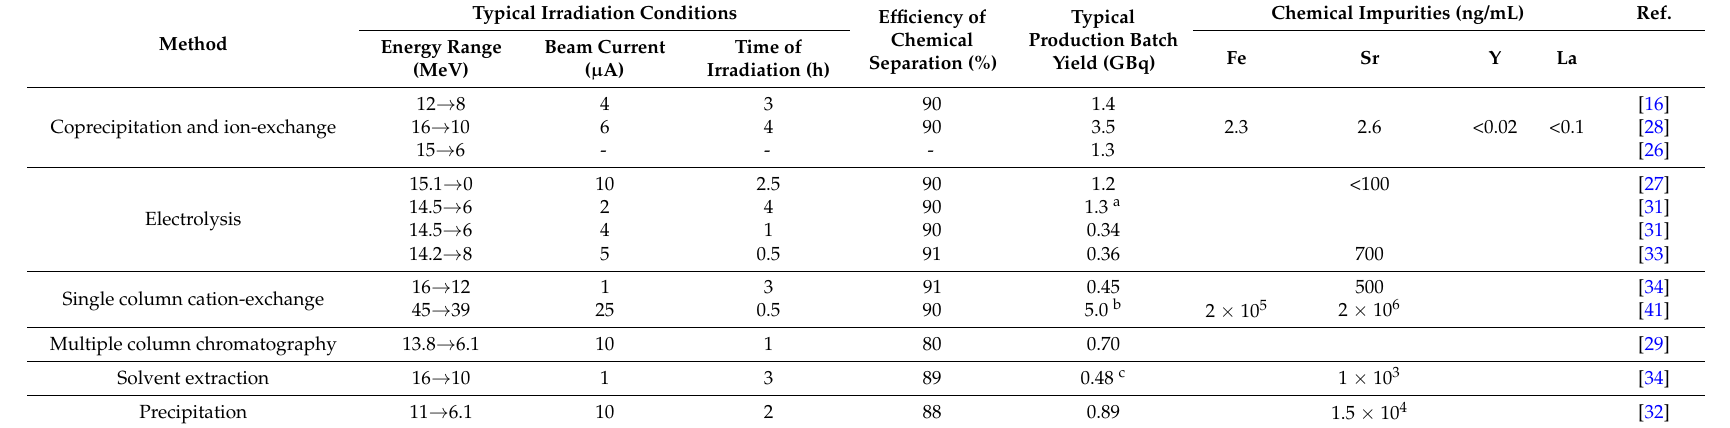
Table 3. Comparison of chemical separation methods of 86 Y from the 86 SrCO 3 target used in real production runs via the (p,n) reaction (unless otherwise